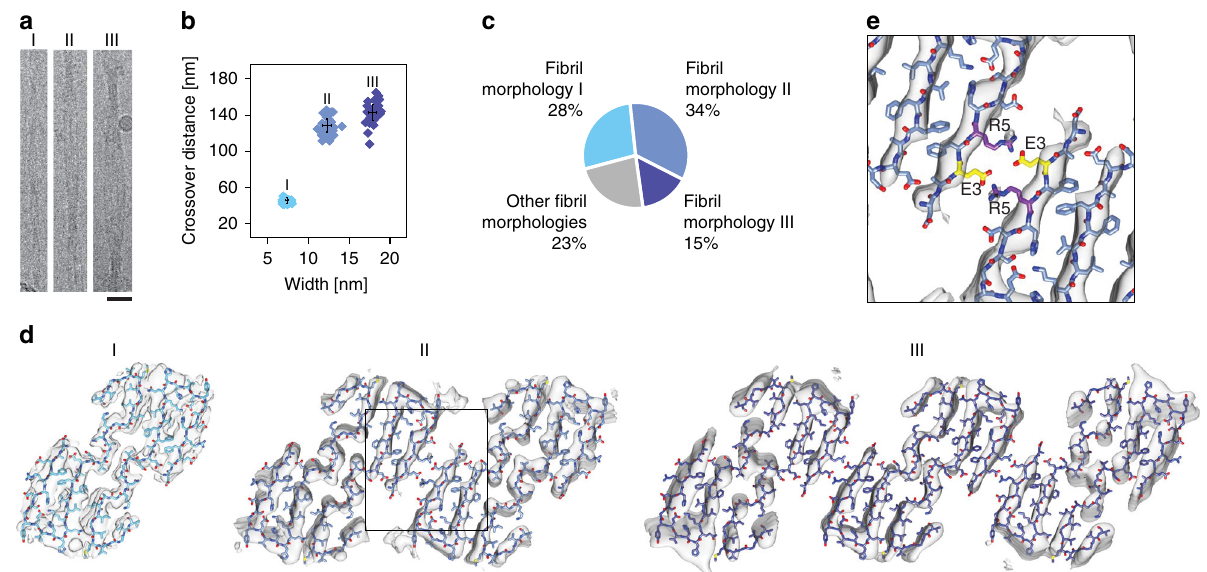
Fig. 4 Polymorphism of brain-derived A β fi brils. a 300 kV Cryo-EM images of fi bril morphologies I − III. Scale bar: 20 nm. b Crossover distance and fi bril width values of fi bril morphologies I − III ( n = 30). Black cross: average value and standard deviation. c Relative abundance of fi bril morphologies I − III in our sample. d Cross-sectional densities of fi bril morphologies I − III (gray) superimposed with the molecular model obtained with fi bril morphology I. e Close-up of the PF − PF interface of fi bril morphology II, indicated by a box in panel ( d ), showing the juxtaposed residues Glu3 and